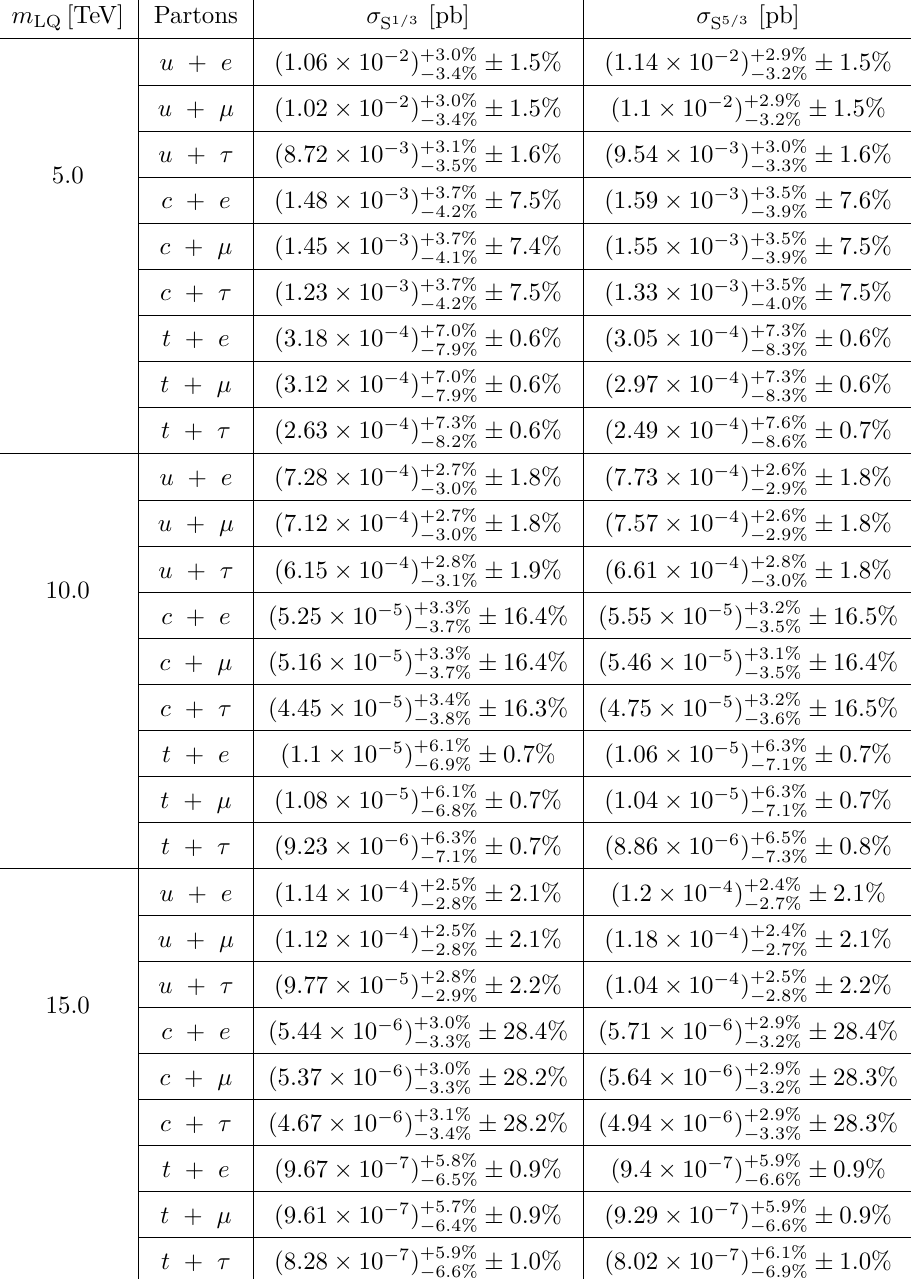
Table 1 . Inclusive cross sections (in pb) at NLO for the resonant leptoquark production pp → LQ √ plus pp → LQ at s = 100 TeV from up-type quarks and charged leptons. For each flavour combination q‘ reported in the second column, the associated Yukawa coupling in eq. (2.1) is = 1 while y R = 0 . The last two columns are for scalar leptoquarks with electric charges ± 1 / 3 y L q‘ q‘ and ± 5 / 3 , respectively. The two displayed uncertainties are due to the scale variations (first) and PDF replicas (second). See section 3.1 for